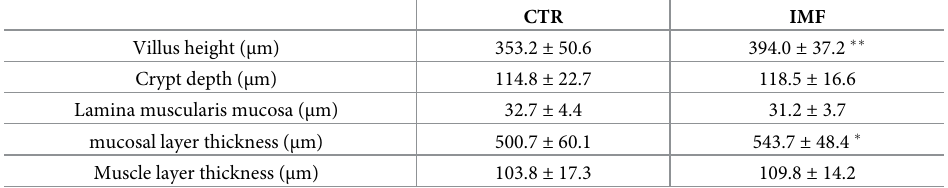
Table 3. The morphometry of intestinal villus height, crypt depth, lamina muscularis mucosa, mucosal layer thickness, and muscle layer